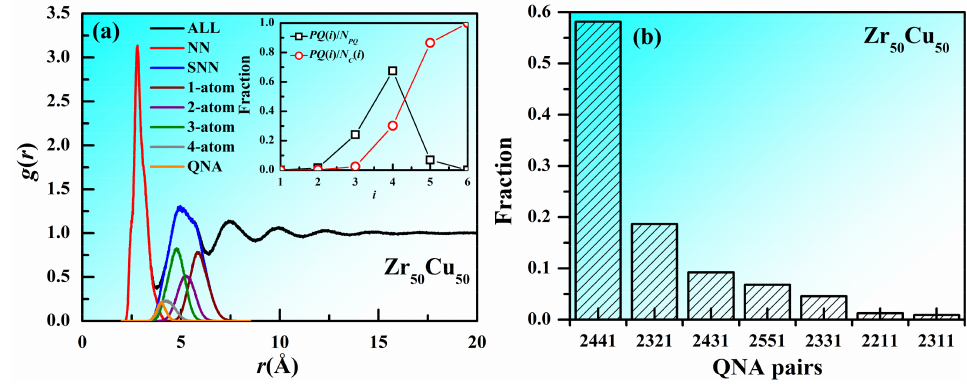
Figure 2. Correlation between QNA and cluster connection in Zr 50 Cu 50 MG at 300 K. ( a ) pair distribution function g(r) for Zr 50 Cu 50 MG at 300 K. The decomposed pair distribution function for the nearest neighbors (NN), second nearest neighbors (SNN) via one-atom, two-atom, three-atom, and four-atom cluster connections and QNAs, are also included. Insets are the fractions of PQ ( i )/ N PQ and PQ ( i )/ Nc ( i ) as a function of the number of shared atoms ( i ) in cluster connections. PQ ( i ) is the number of QNA pairs with i-atom cluster connection, N PQ is the number of all the QNA pairs and Nc ( i ) is the number of i -atom cluster connections. ( b ) Distribution of different types of QNA